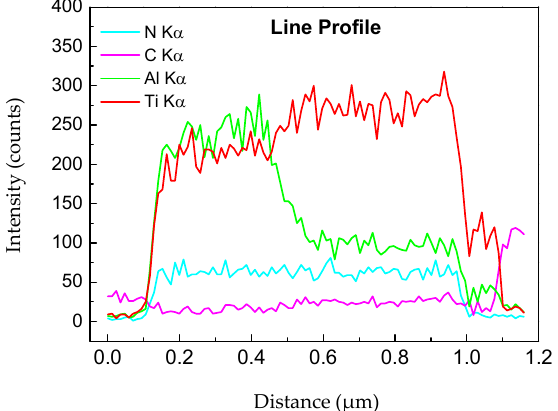
Figure 8. EDS linear profile of selected detected elements.